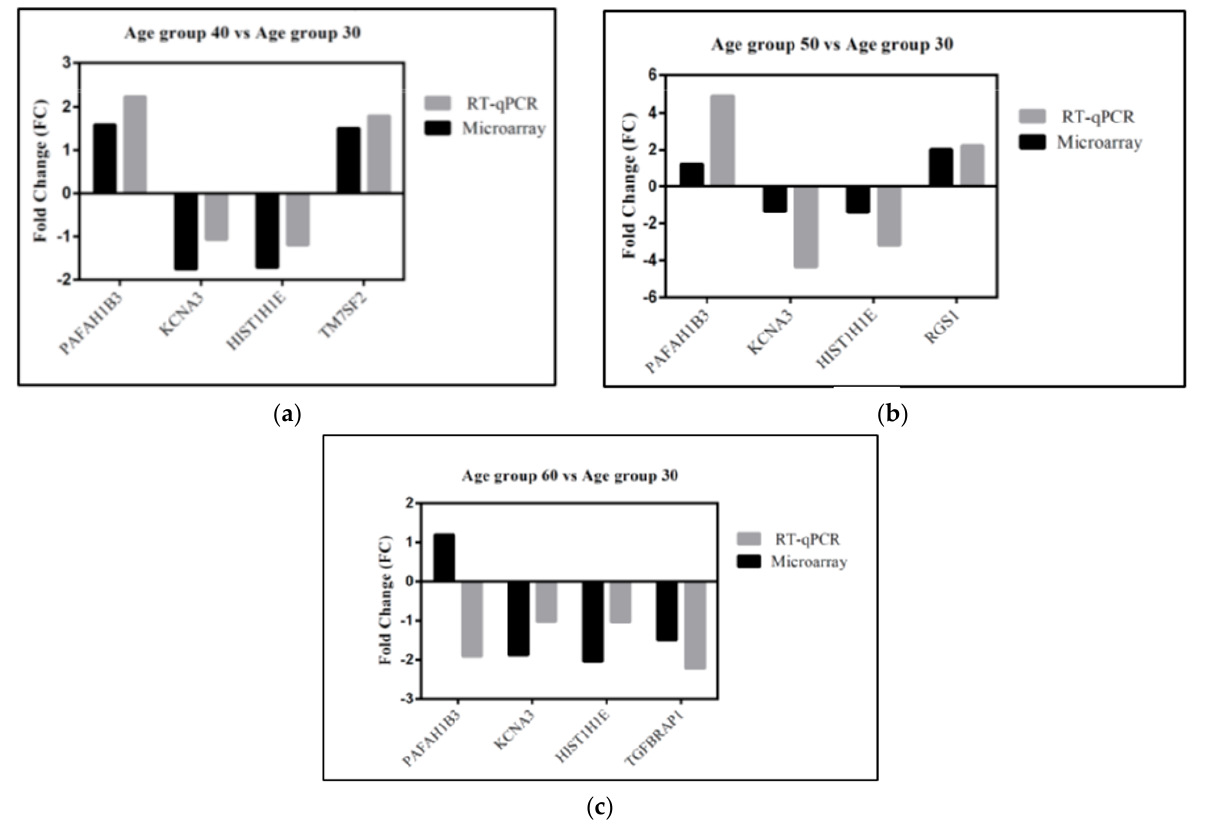
Figure 6. Quantitative validation of gene expression by qRT-PCR using selected genes from microarray experiment ( a ) age group 40 vs. age group 30, ( b ) age group 50 vs. age group 30, and ( c ) age group 60 vs. age group 30.